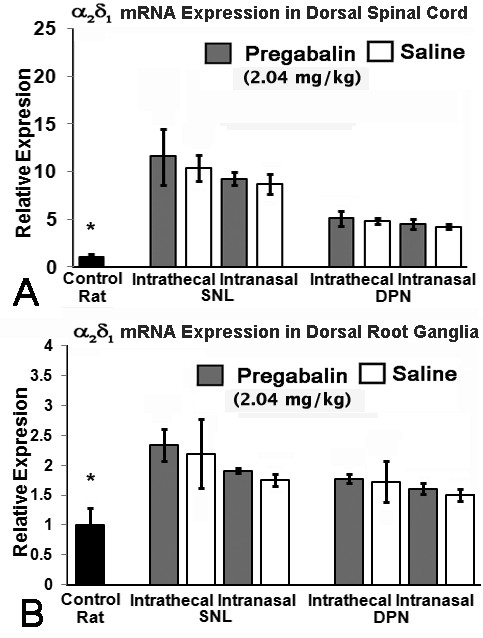
Expression of CACNA2D1 mRNA. Expression of CACNA2D1 mRNA was upregulated in both dorsal spinal cord (A) and lumbar DRGs (B) in the presence of either diabetic peripheral neuropathy (DPN) or spinal nerve ligation (SNL). Dorsal horn mRNA expression was unchanged by presence of high dose pregabalin (2.04 mg/kg/d) provided either through intrathecal or intranasal delivery when compared to saline delivery (A). There was no impact of pregabalin delivered in any manner upon mRNA expression in lumbar DRGs when compared to saline delivery, although the presence of spinal nerve ligation or diabetic peripheral neuropathy was associated with elevated CACNA2D1 mRNA expression when compared to control rat specimens (B), indicated by the * above the Control rat data (non-matched ANOVA tests, F-values range between 0.42-1.00 for indicated groups and time points, n ≥ 3, * p < 0.0125) [n = 6-8 specimens for each cohort].